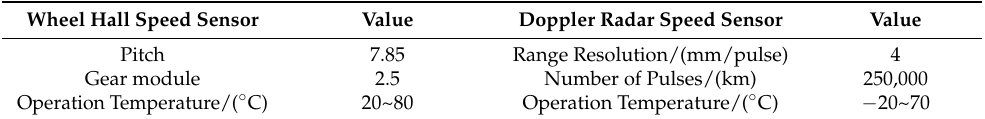
Table 2. Speed sensors